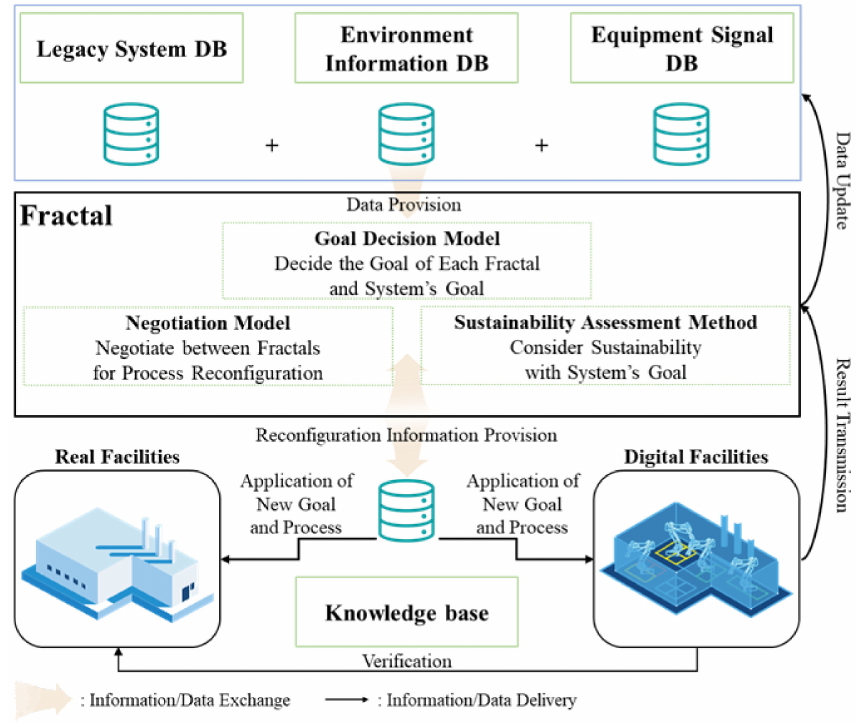
Figure 10. Data-driven modeling of big data for SSrMS.